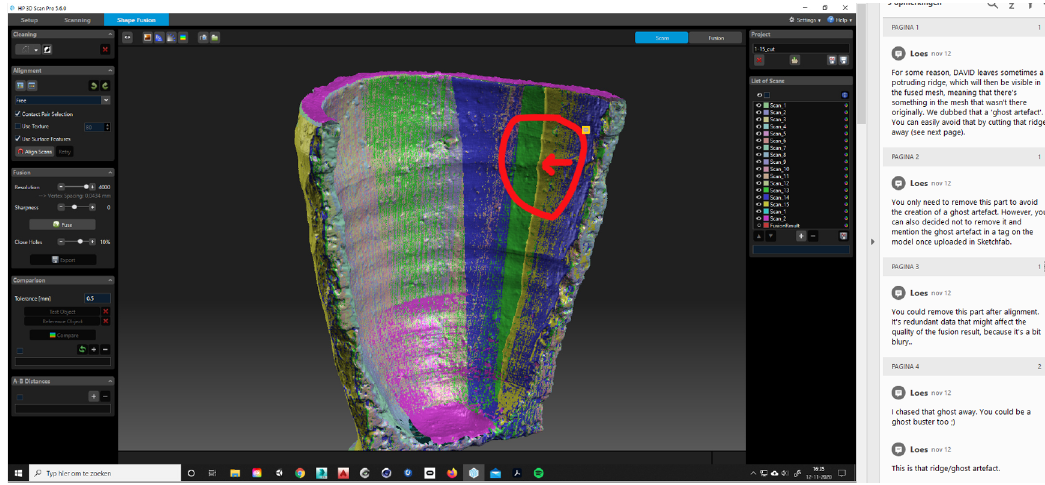
Figure 5: Online training, assessment, and feedback to Kelly by the author. Image by the